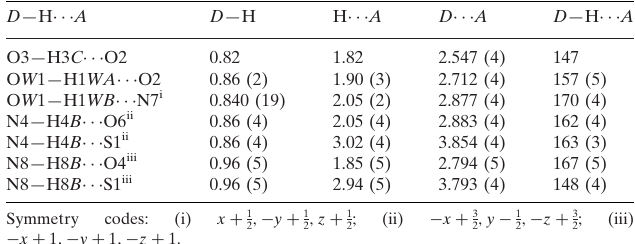
Hydrogen-bond geometry (A˚ , (cid:3)